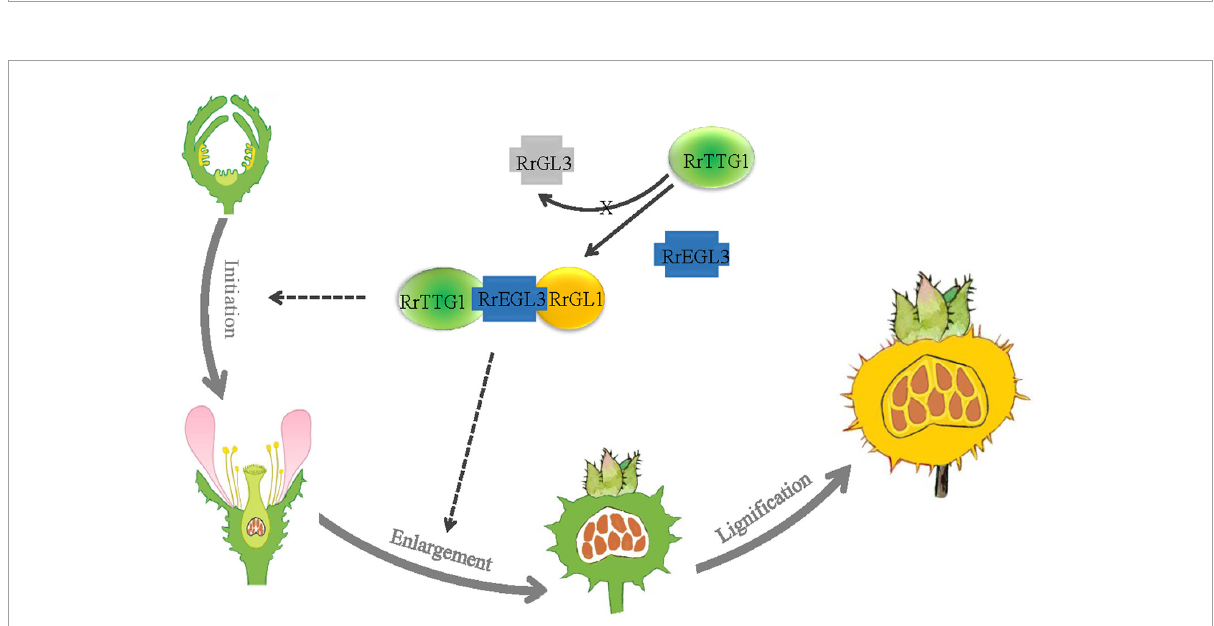
FIGURE8 Model of RrTTG1 function in fruit prickles formation in R. roxburghii . Fruit prickles’ formation undergoes three stages: initiation, enlargement, and lignification. RrTTG1 only interacts with RrEGL3 to form the RrTTG1-RrEGL3-RrGL1 complex and fails to interact with RrGL3. The RrTTG1-RrEGL3-RrGL1 are highly expressed from fruit prickle primordia to young fruit prickle. Thus, RrTTG1-RrEGL3-RrGL1 might modulate the primordia initiation and enlargement of fruit prickles in R. roxburghii . The lines and dotted lines represent the results and speculations,